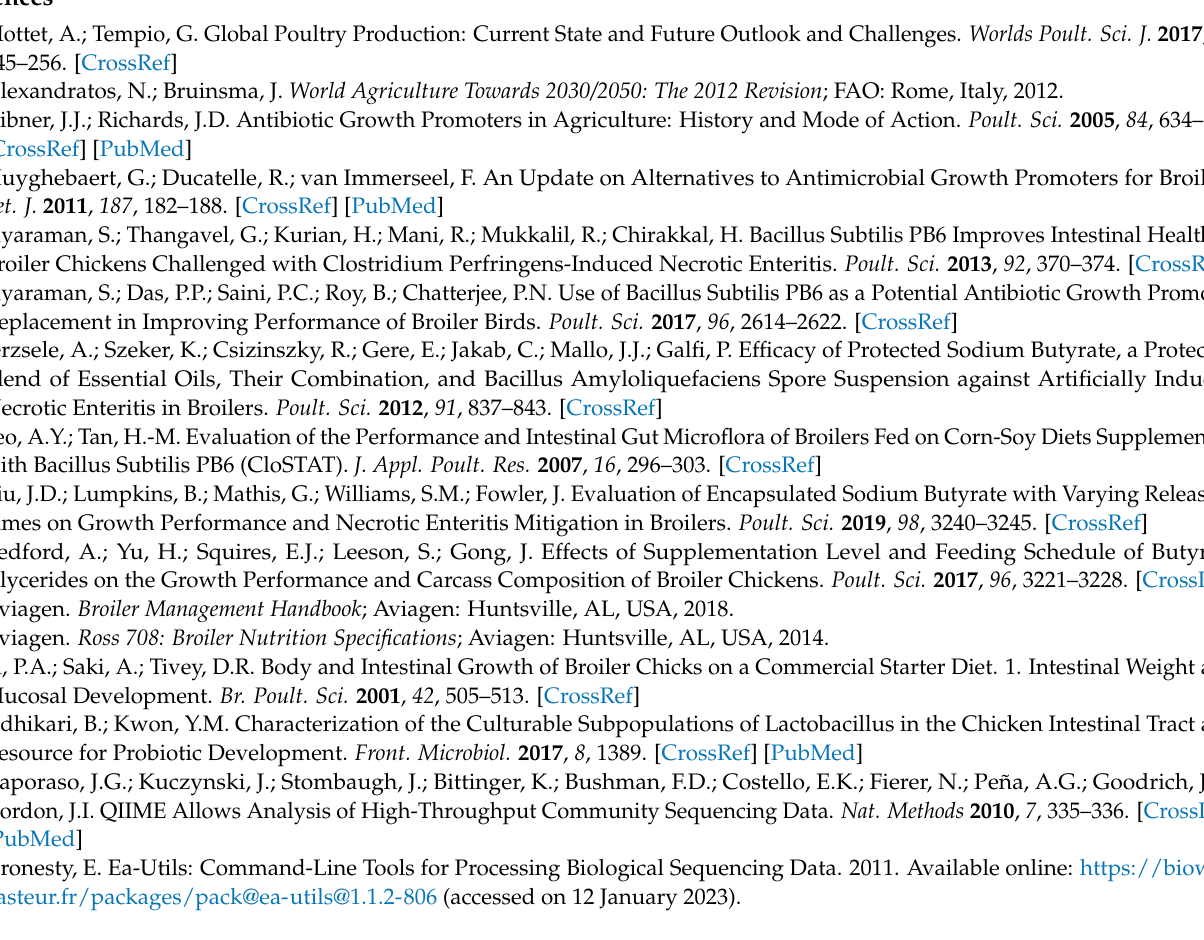
Table S2. Summary of the taxonomic groups in jejunal samples that showed significant difference among the treatment groups based on different